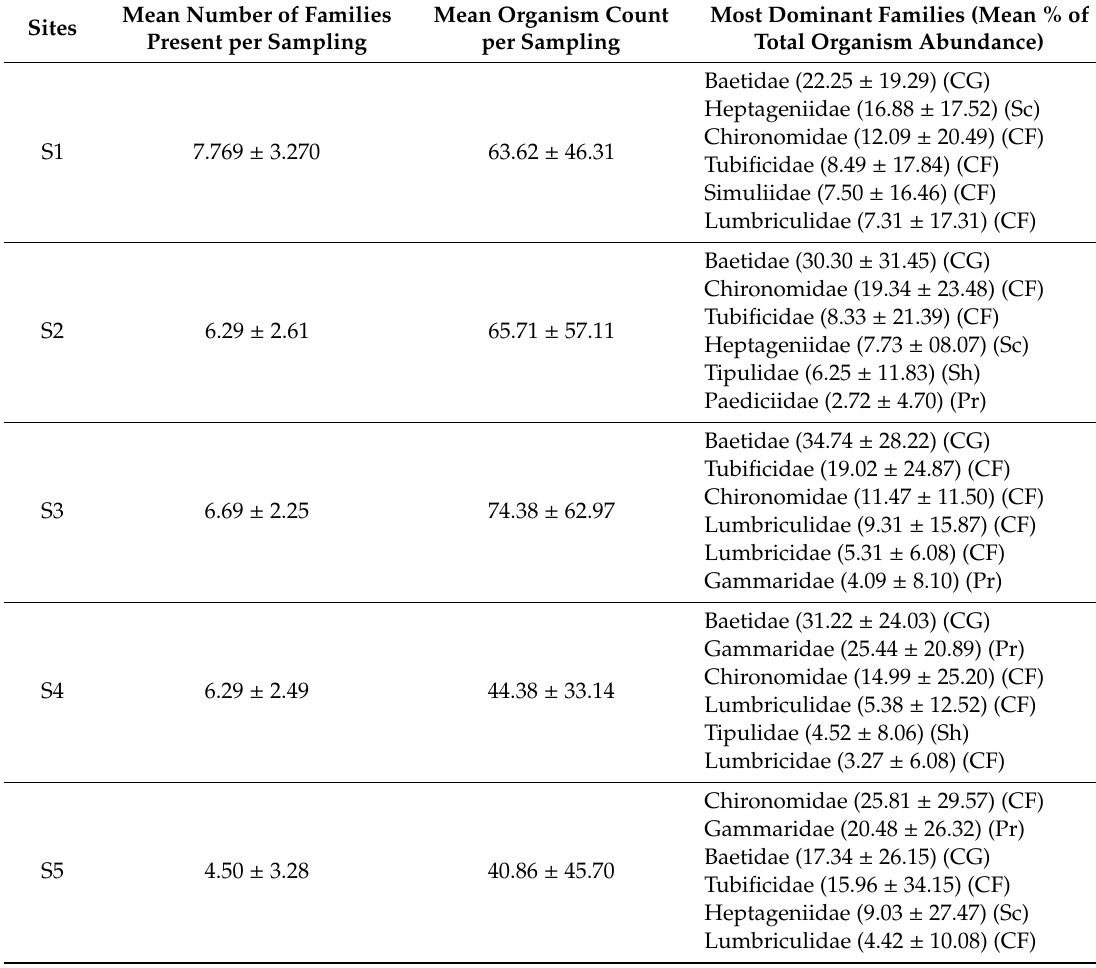
Table 2. Benthic macroinvertebrate assemblages identified at S1 to S5, including the mean ± SD for each family identified per sample, total organisms identified per sample and the dominant group for each study site. The families were also classified based on their functional feeding groups